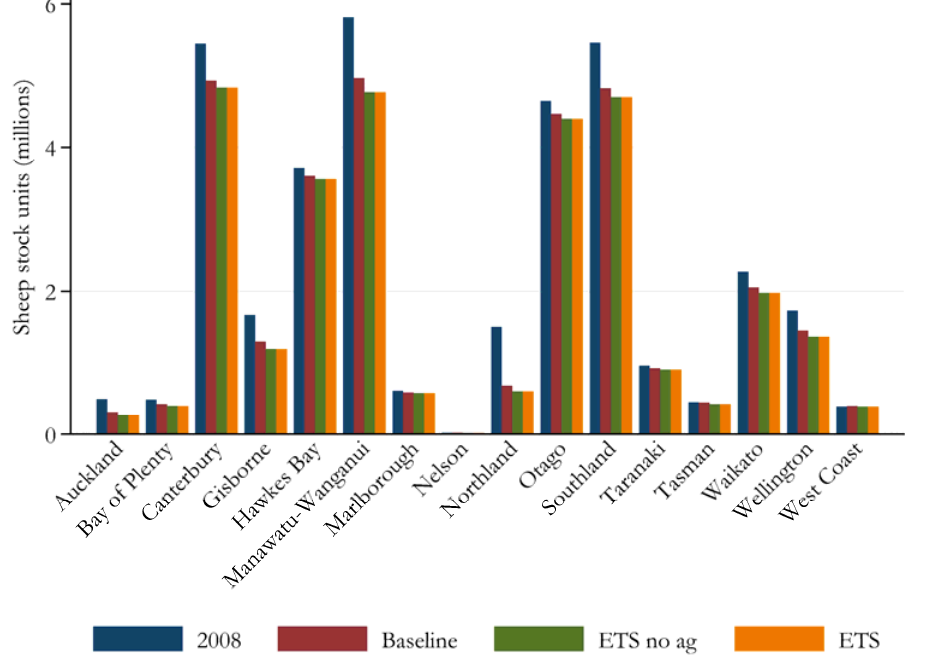
Figure 6. Sheep stock units by region in 2008 and in 2030 policy scenarios. Blue bars show LURNZ estimates of the total stock units by regional council in 2008. Red, green and orange bars show, respectively, projected output in 2030 under the baseline, with an ETS that does not include agriculture, and under the full ETS. Details on stock unit projections are in Timar